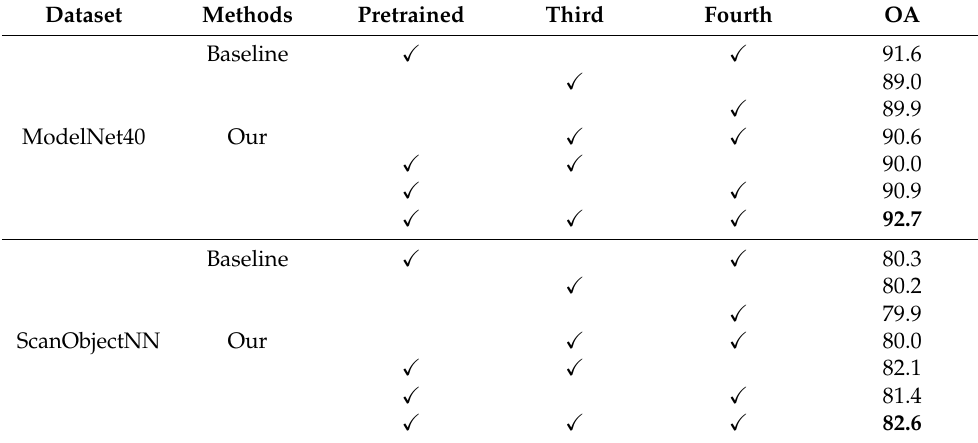
Table 4. Ablation experiment